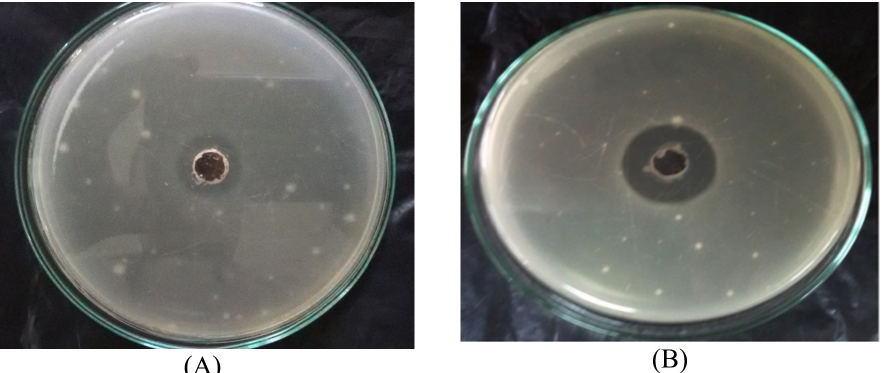
Fig. 5 . Inhibition zone diameter of Streptomyces MK388207 (M12) supernatant grown on basal medium (A) compared with the verified medium (B) against Candida albicans ATCC10231